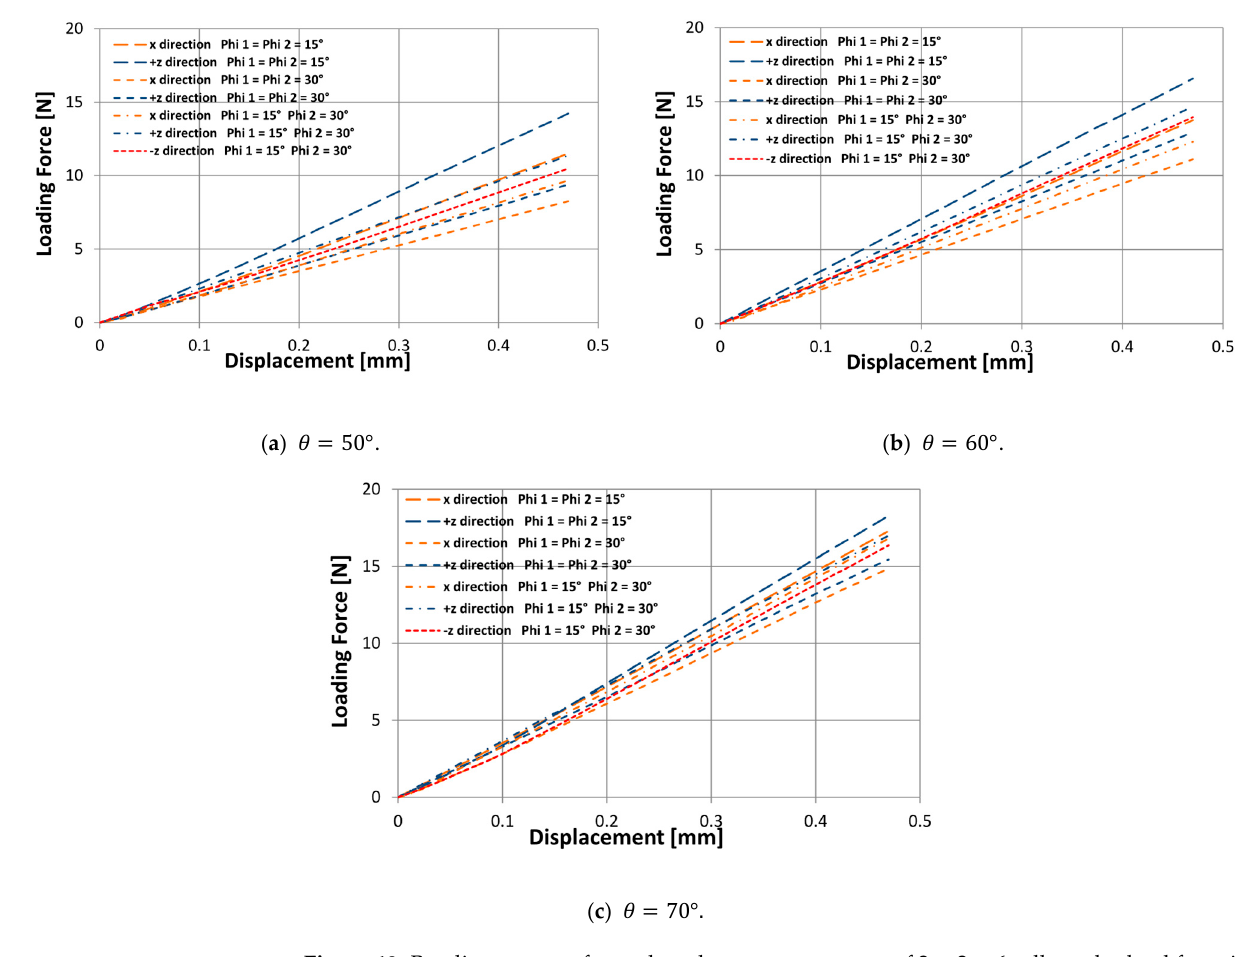
Figure 13. Bending tests performed on the macrostructures of 2 × 2 × 6 cells under load force in the x , + z , and − z directions.